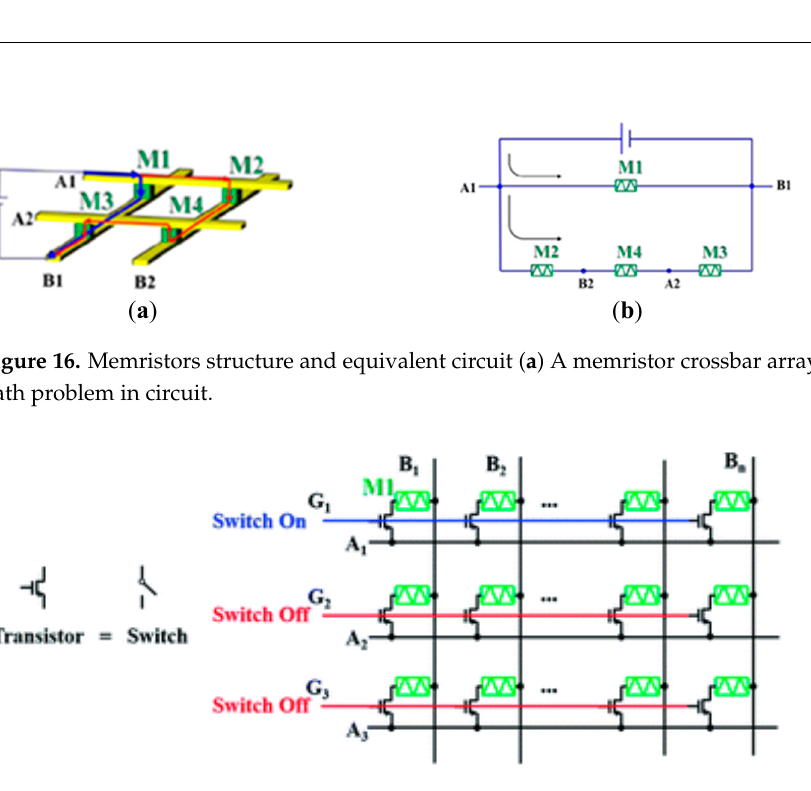
11 of 16 Figure 14. Simulation of a 4 bit binary-weighted DAC cell. Figure 15. INL simulation for a 4 bit input memristor-based binary-weighted DAC circuit. 4.4. Sneak Path Problem in a Binary-Weighted DAC-Based Memristor One of the crucial obstacles for an efficient memristor crossbar array and a cascaded memristor is the so-called sneak path current problem. Some general reviews [21–25] deal- ing with the fundamental mechanisms, materials, and architectures of memristors have partially addressed the sneak path current problem and its solutions. Figure 16a shows the crossbar array that includes sneak path issues, whereas Figure 16b shows the equiva-